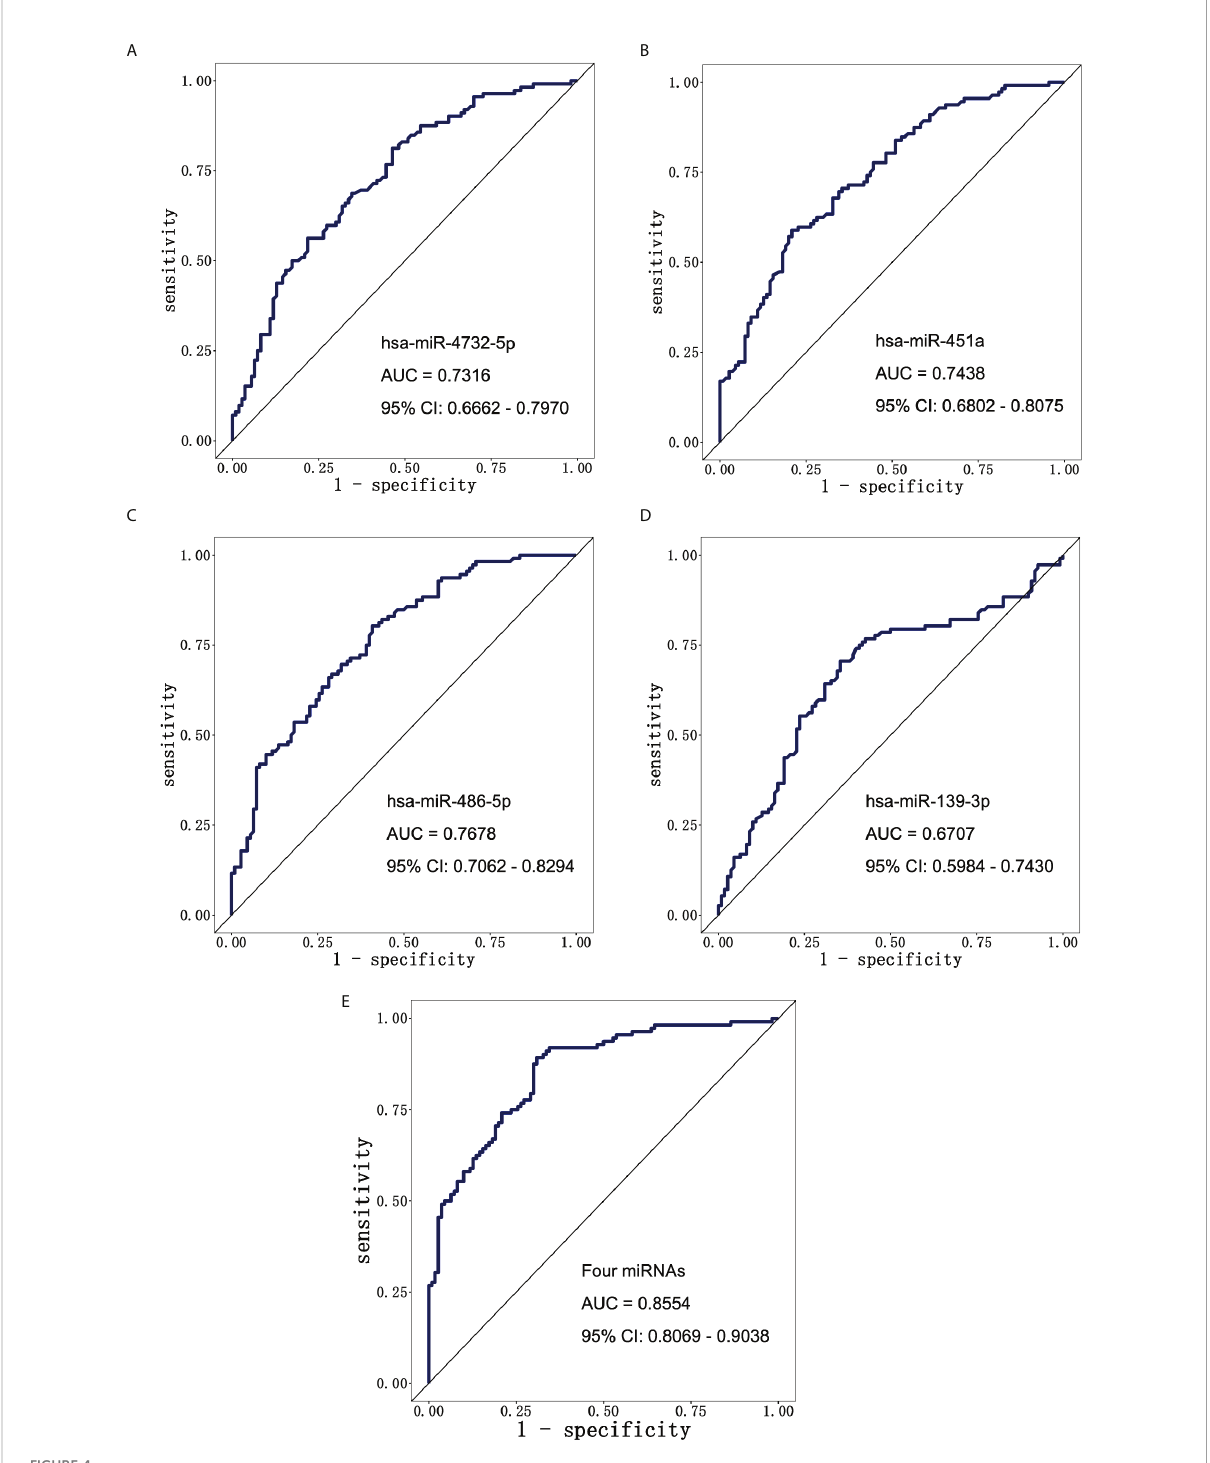
FIGURE 4 The diagnostic potential of candidate miRNAs. ROC curve analysis of (A) hsa-miR-4732-5p, (B) hsa-miR-451a, (C) hsa-miR-486-5p, and (D) hsa- miR-139-3p to differentiate LUAD patients (n = 112) and NCs (n = 110). (E) ROC curve analysis of combining four candidate miRNAs to differentiate LUAD patients (n = 112) from NCs (n = 110). ROC, receiver operating characteristic; LUAD, lung adenocarcinoma; NCs, normal